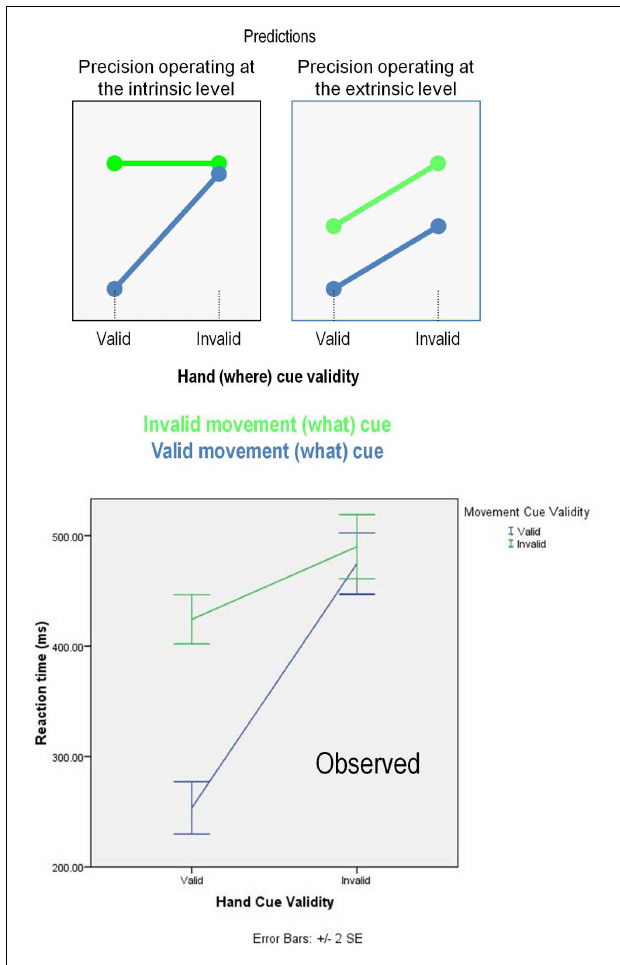
FIGURE 4 | Reaction time effects for the four combinations of cue validity: the top panels show the results predicted by the theoretical architectures of Figure 2. The green lines correspond to valid movement cues and the blues lines to invalid movement cues.The empirical results are shown in the lower panel using the same colors.The bars correspond to SE over subjects.The form of the interaction observed is very close to that predicted under a model where attention biases prediction errors in an intrinsic frame of reference ( Figure 2 ).